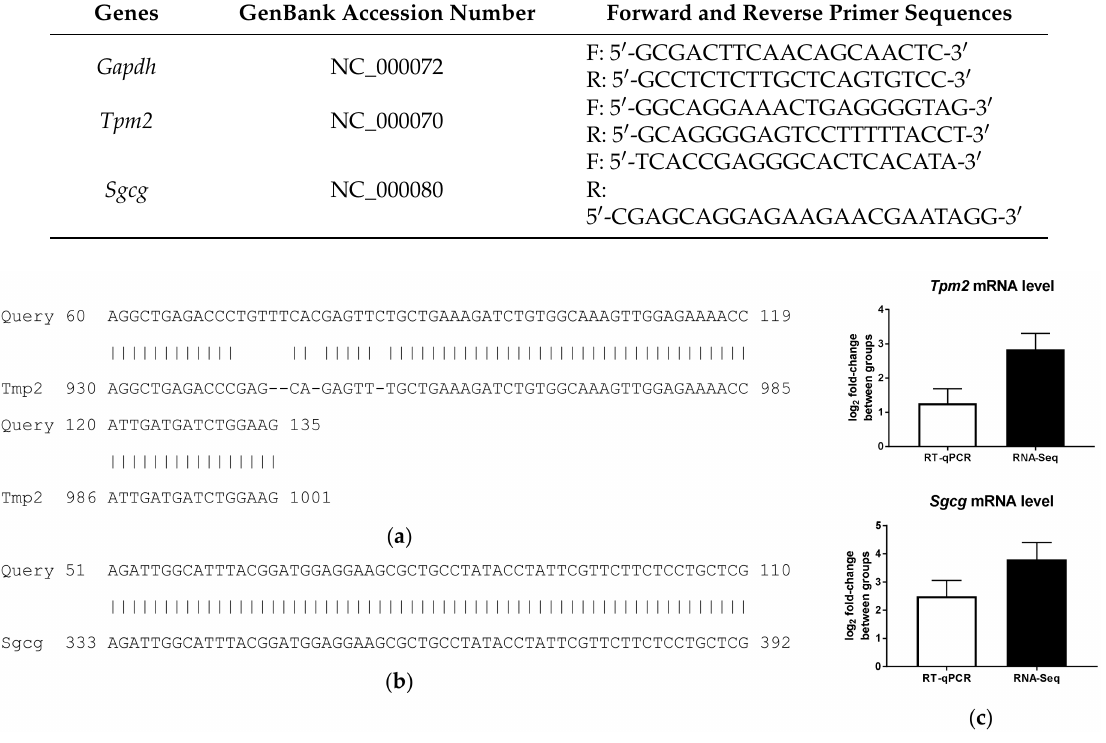
Figure 5. Validation of RNA sequencing (RNA-Seq)-based expression of tropomyosin 2 ( Tmp2 ) and sarcoglycan gamma ( Sgcg ) genes using reverse transcription-quantitative PCR (RT-qPCR). ( a ) PCR product Tmp2 sequenced using Sanger sequencing and mapped to NCBI Blast revealed 91% match with 69/76 match and 4/76 gaps; ( b ) PCR product Sgcg sequenced using Sanger sequencing and mapped to NCBI Blast revealed 100% match with 60/60 match and no gap; ( c ) RNA-Seq- and RT-qPCR-determined log 2 fold-changes of Tpm2 and Sgcg